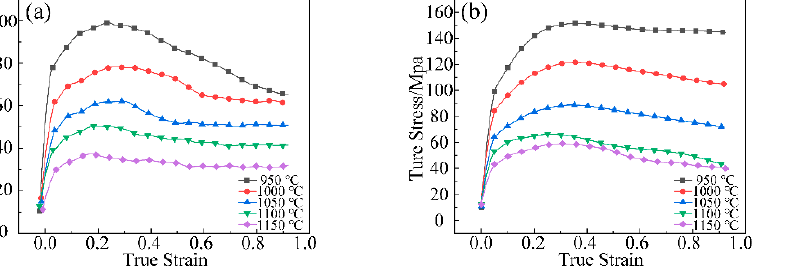
ε=  . . ε = 0.01 ( b ) ε = 0.1 ( b )